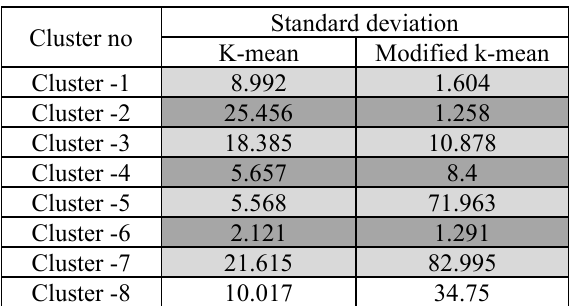
Table 8. Numbers Of Accesses For Each Cluster